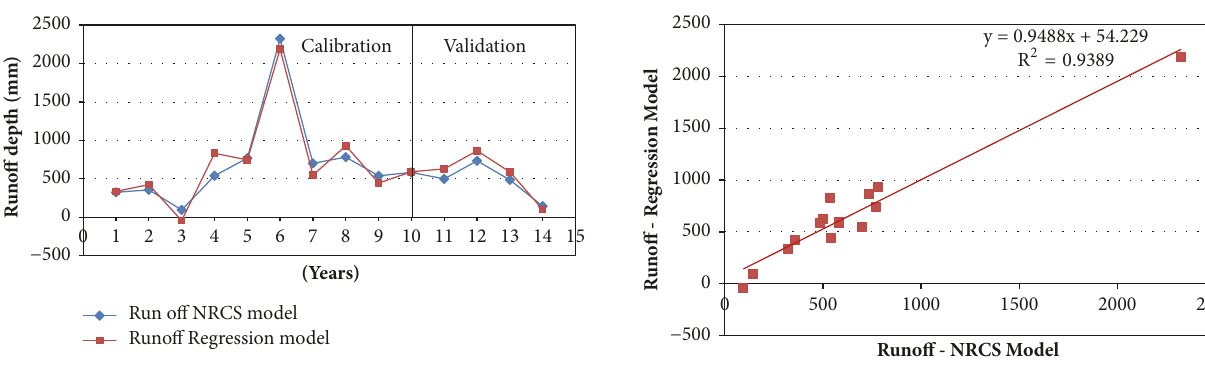
Figure 9: Scatter plot of annual runoff by NRCS model and regression model for Urapakkam watershed for 2000-01 to 2013-14.